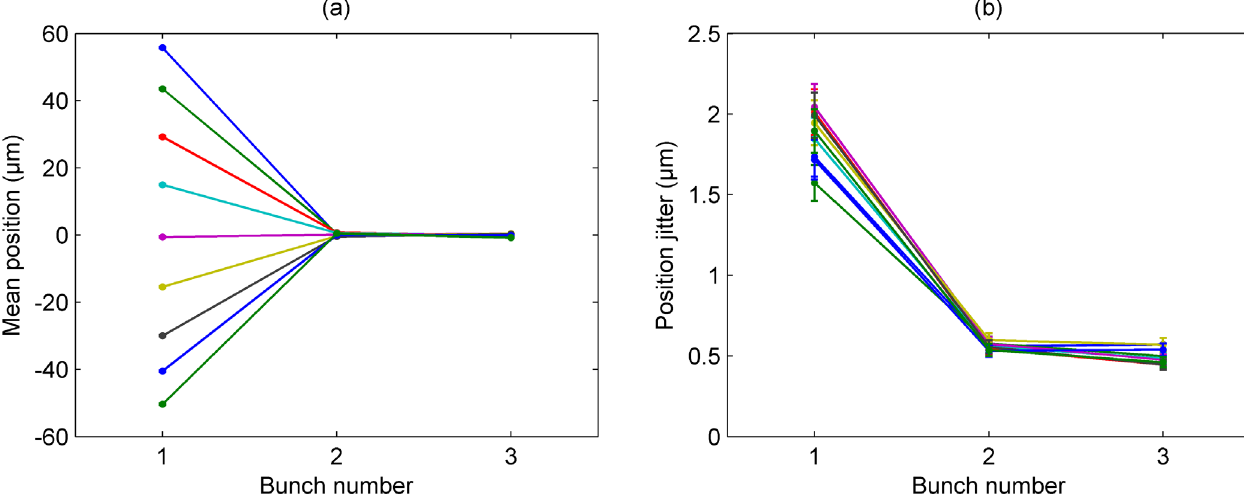
FIG. 18. (a) Mean position and (b) position jitter measured at P3 with feedback on versus the bunch number for nine incoming beam orbit settings (color coded). Standard errors are given.